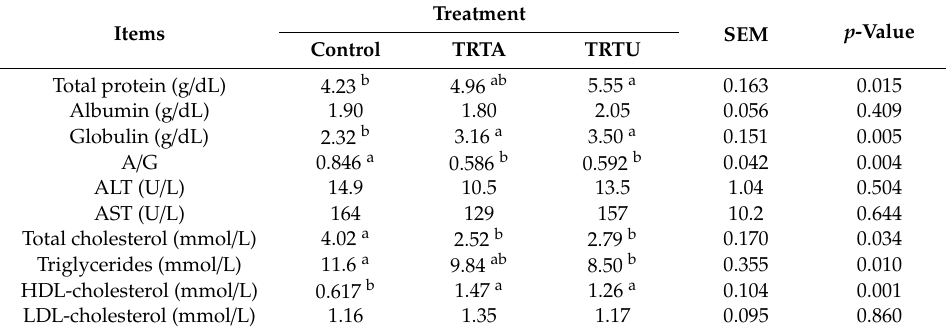
Table 6. E ff ects of dietary U. cannabina supplementation on blood biochemical parameters of laying